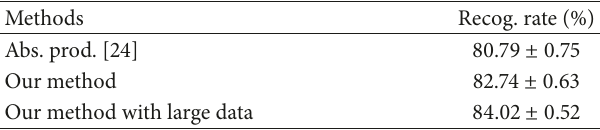
Table 2: Recognition rates of the method used in [24] and performance of our method with large training data.